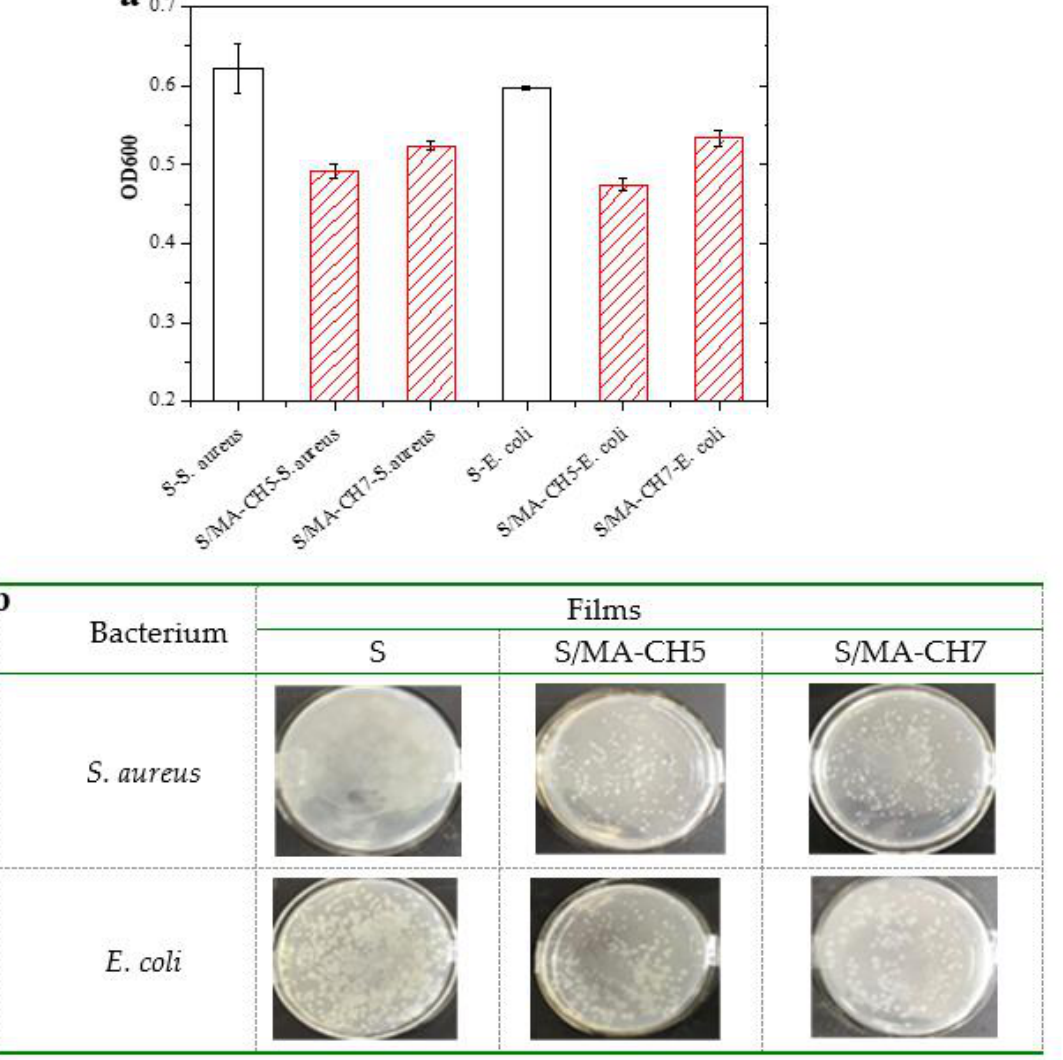
Figure 7. Inhibitory effect ( a ) of S films, S/CH 5% films, S/CH 7% films, S/MA-CH 5% films and S/MA-CH 7% films against S. aureus and E. coli , and pictures of agar plates ( b ) inoculated by 100 μL of diluted broth from the corresponding flask. Pictures were taken after 24 h of cultivation.